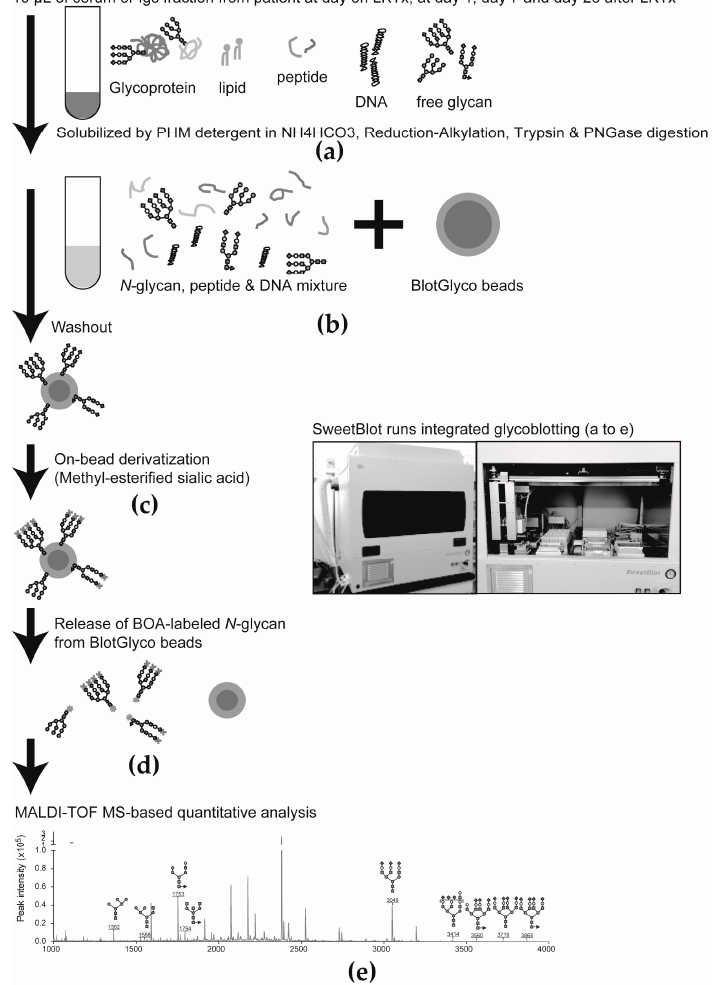
Figure 8. The general protocol for the integrated glycoblotting technique and workflow for glycoblotting-based high-throughput clinical glycan analysis. ( a ) Ten-microliter serum samples are applied to SweetBlot TM for glycoblotting; ( b , c ) After enzymatic cleavage from serum protein, total serum N- glycans released into the digestion mixture were directly mixed with BlotGlyco H beads to capture N- glycans; ( d ) After the beads are separated from other molecules by washing, sialic acid is methyl esterified; ( e ) These processed N- glycans are then labeled with BOA and released from BlotGlyco H beads; ( f ) Mass spectra of BOA-labeled N- glycans are acquired by using an Ultraflex III